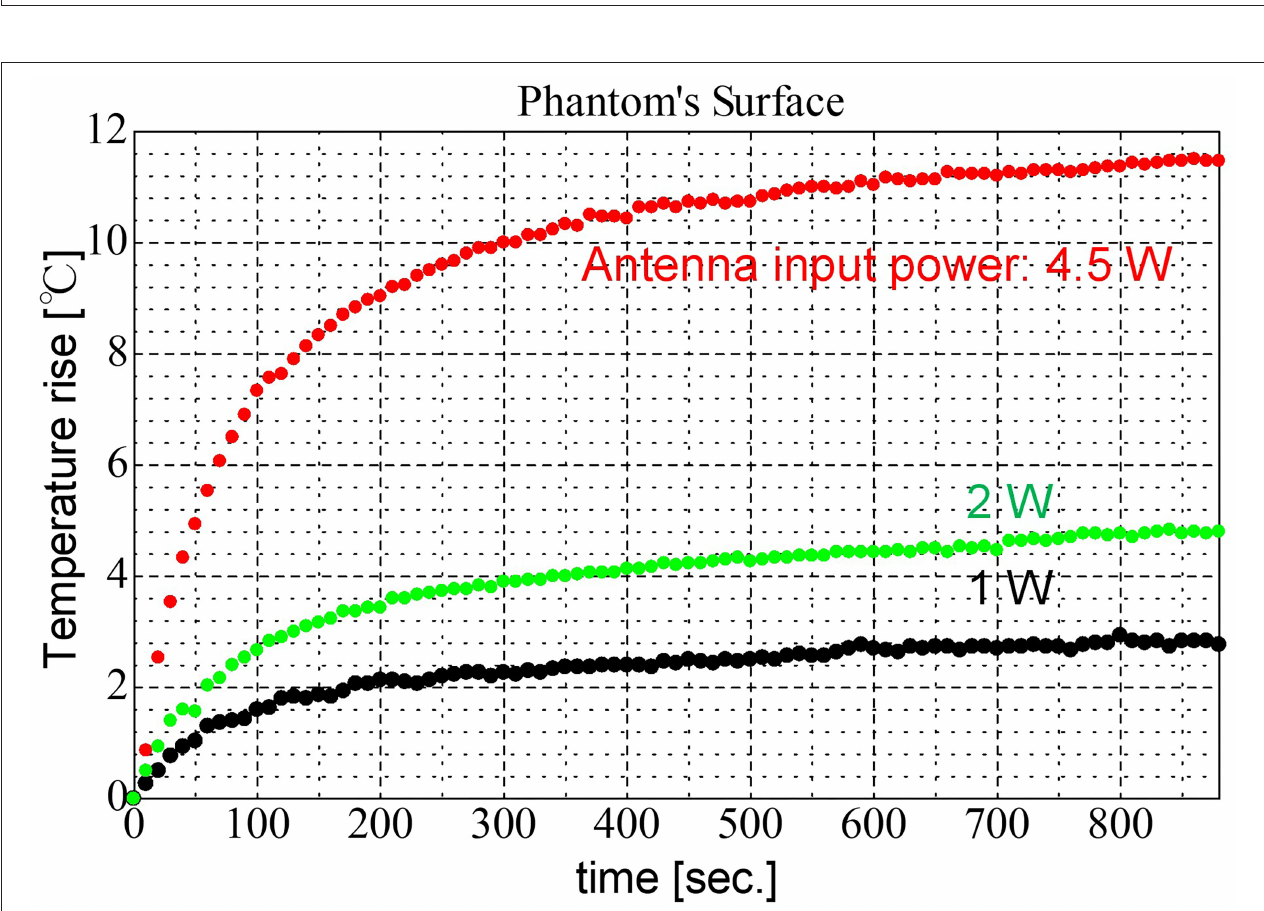
FIGURE 8 | Characteristics of temperature elevation during the exposure to 60 GHz MMW with orthogonal polarized feeding.